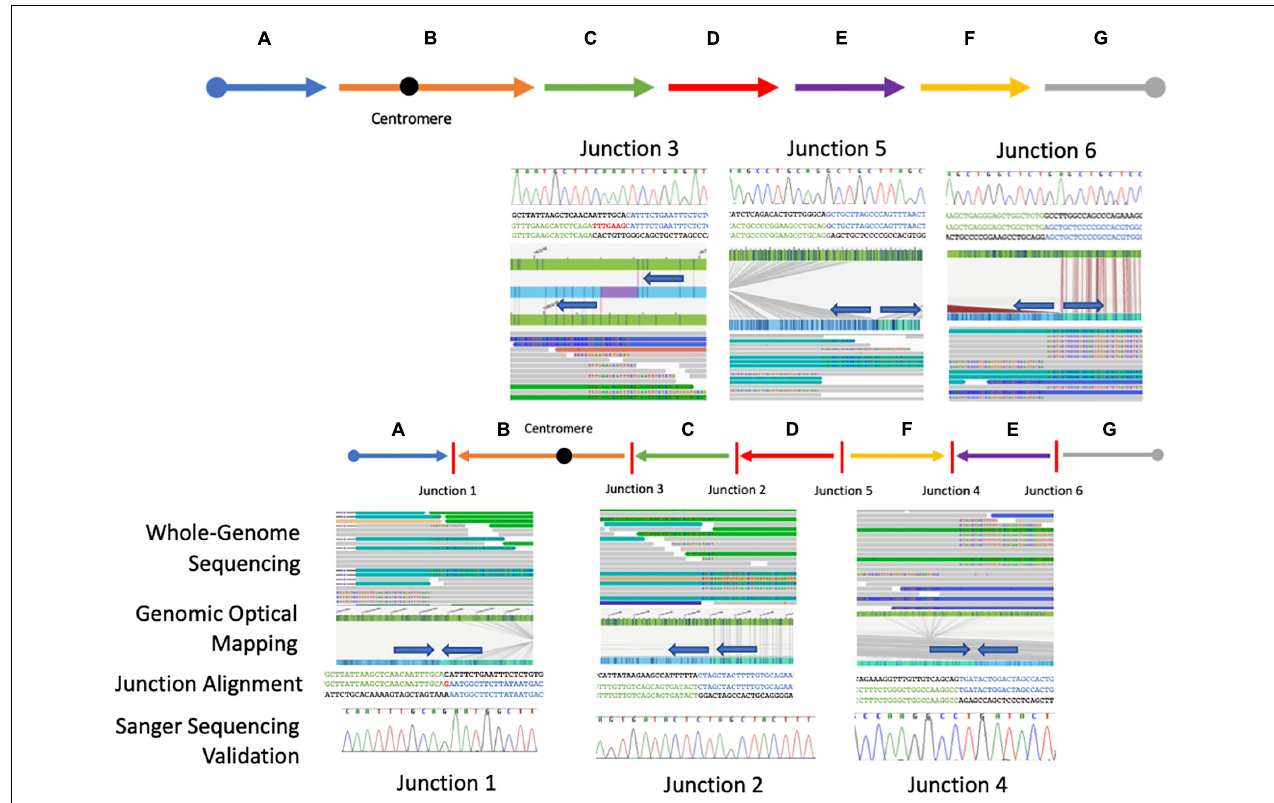
FIGURE 2 | Resolved breakpoint junctions as visualized by multiple genomic technologies. The final resolved chromosome 6 structure showing each genomic fragment orientation and the six breakpoint junctions as visualized through each technology applied including whole-genome sequencing, genomic optical mapping, breakpoint-junction alignment, and final Sanger validation. The colored arrows at the top represent the reference orientation of each genomic fragment. The arrow orientation in the middle represents the orientation of each genomic fragment in this patient with respect to